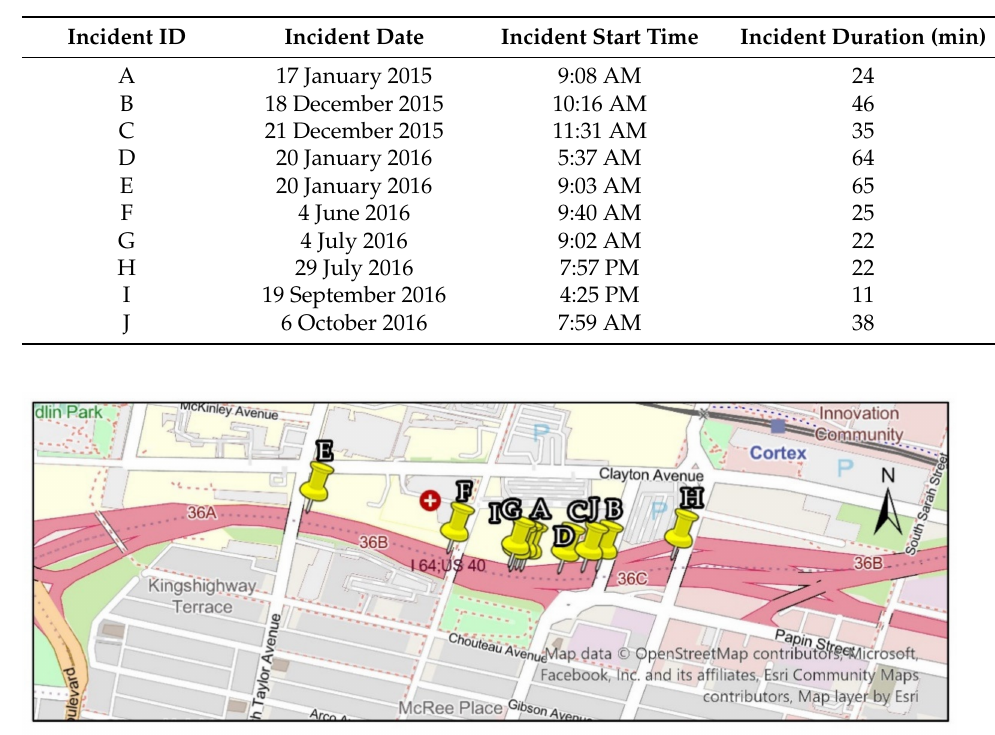
Table 1. Incidents modeled in the simulation testbed.